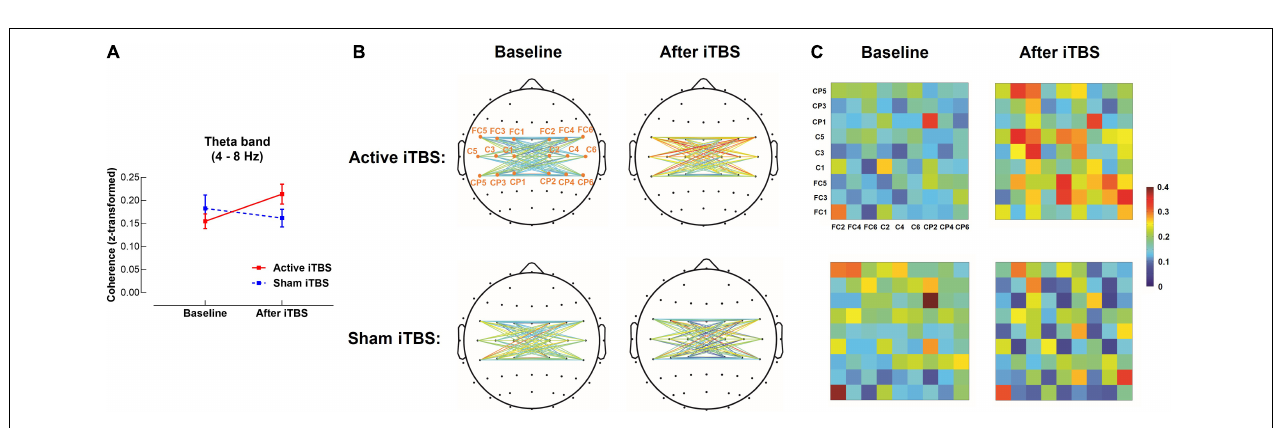
FIGURE 1 | Delta band interhemispheric functional connectivity change after iTBS. Delta band coherence between left and right sensorimotor cortices was significantly increased in the Active iTBS group, but not in the Sham iTBS group after iTBS (A) . The topographies (B) and matrixes (C) represent z-scores of coherences between pairs of electrodes in the left and right sensorimotor cortices before and after iTBS in the Active and Sham iTBS groups. Warmer colors indicate greater coherence, while cooler colors indicate less coherence.